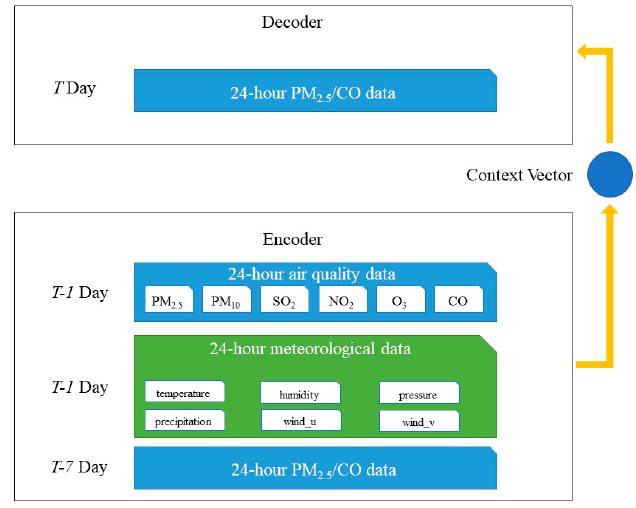
Figure 4. The framework of the Seq2Seq model with weekly periodicity.